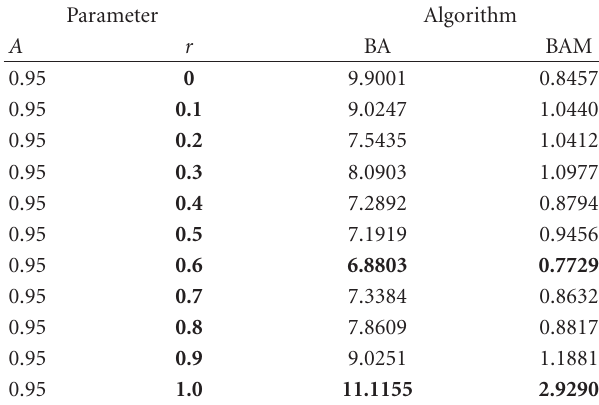
Table 16: Mean normalized optimization results on UCAV path planning problem on di ff erent r . The numbers shown are the minimum objective function values found by BA and BAM algorithms, averaged over 100 Monte Carlo simulations.